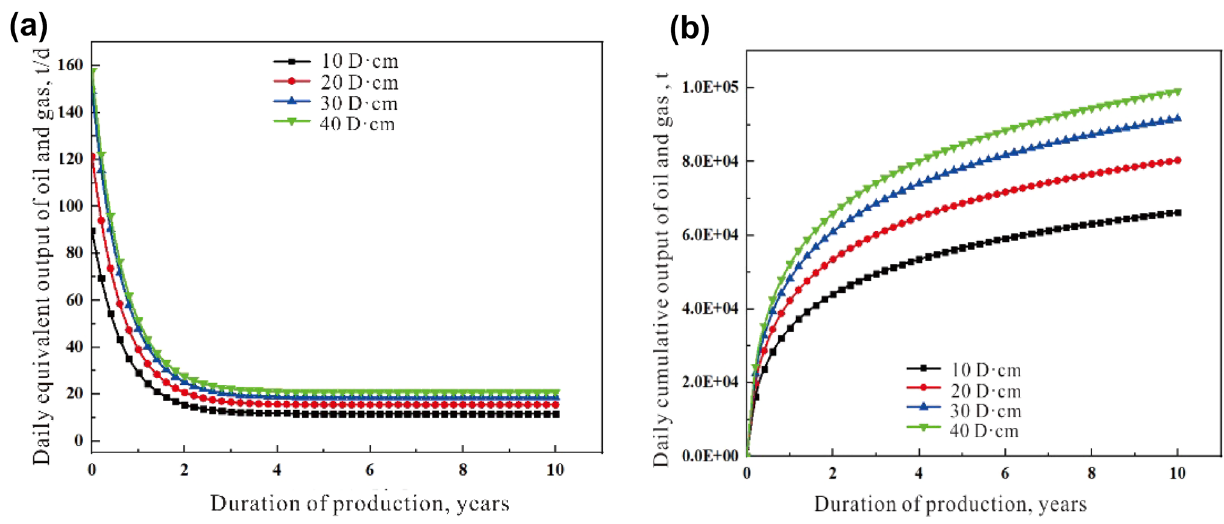
Fig. 4 Daily ( a ) and cumulative ( b ) output under the different conductivity